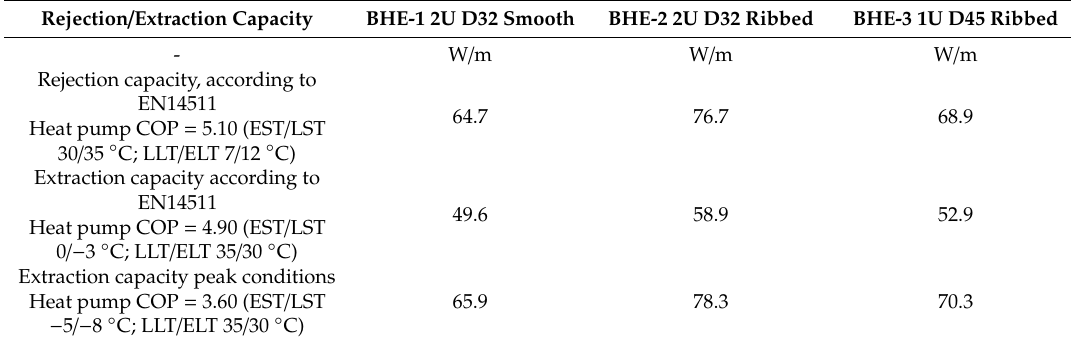
Table 3. Obtained extraction and rejection heat rates from three BHE and from data presented in Figure 8.